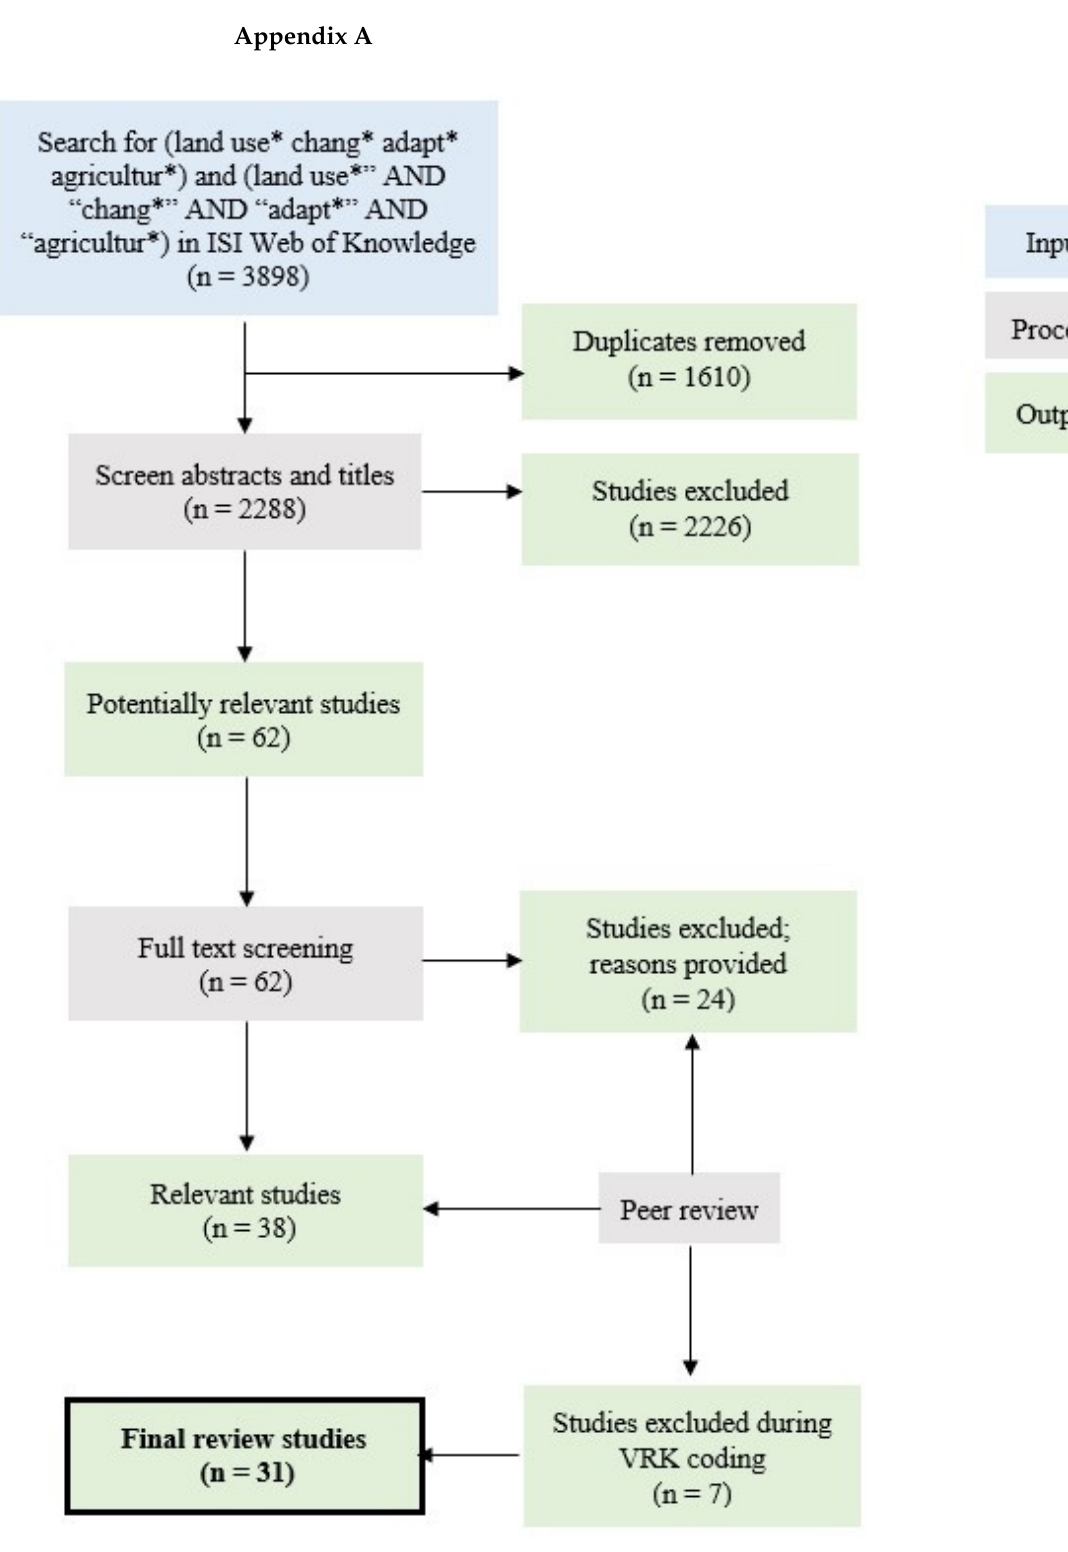
Figure A1. PRISMA Search Flow